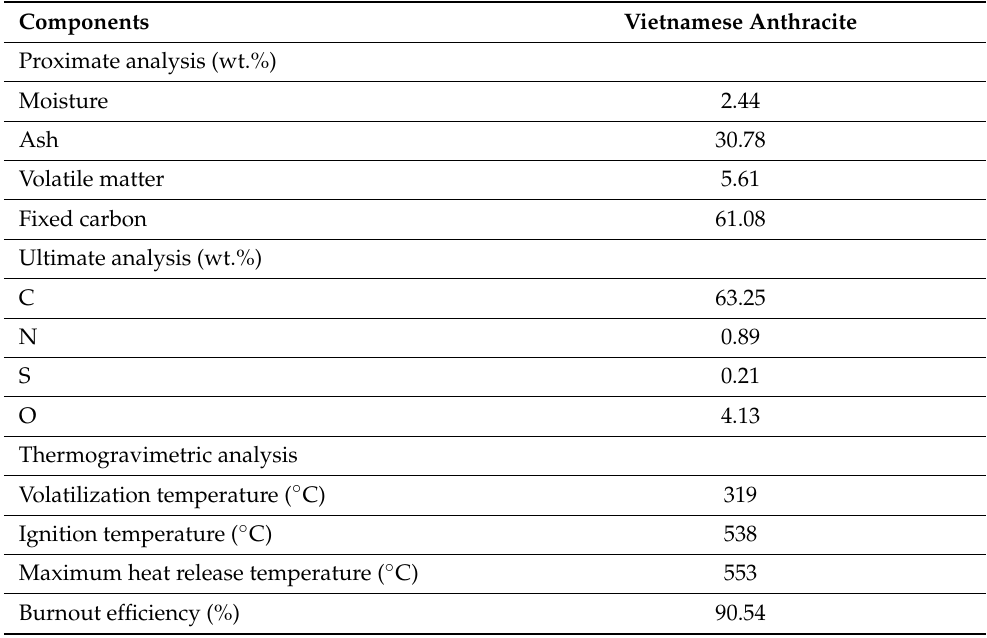
Table 6. Analysis of Vietnamese